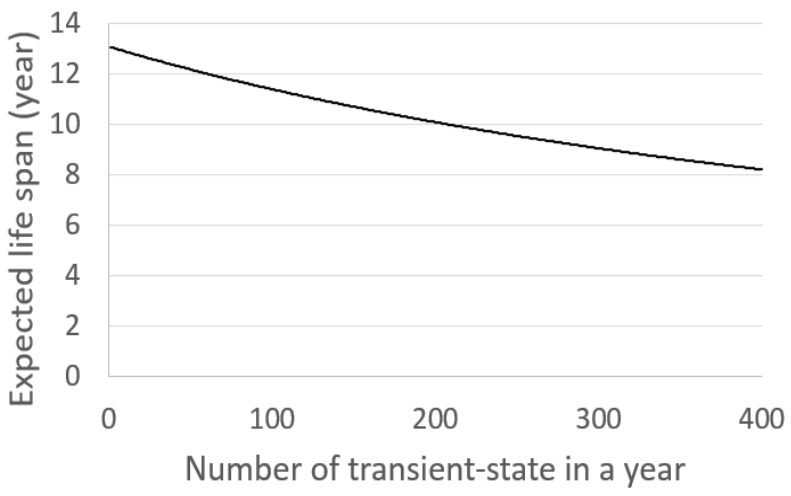
Figure 9. Wear cost for the BESS that costs $4.6 M per a unity 4 C system (4-MW/1-MWh) obtained using the DOD-ACC curve in Figure 4.